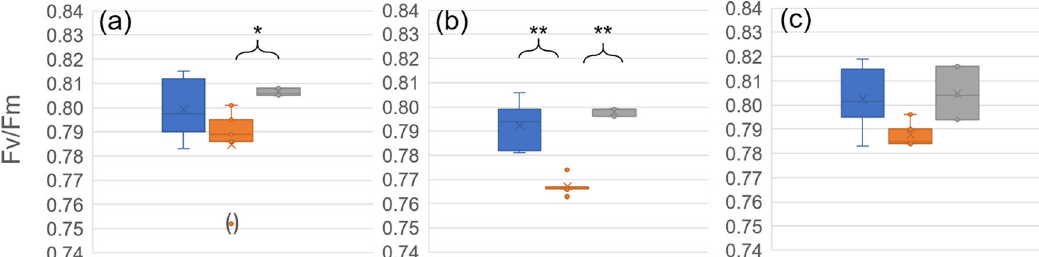
Fig. 3 Maximum photochemical quantum yield of PSII (Fv/Fm) under transient heat. Fv/Fm under 22 °C during the fi rst 2 h of the light phase (blue), during transient exposure to 40 °C (orange) and after 2 h of recovery at 22 °C (gray). a Col-0, b pgm1 , c spsa1 . Box-and-whisker plots: center line, median; box limits, upper and lower quartiles; whiskers, 1.5× interquartile range; points, outliers. Asterisks indicate signi fi cant differences (ANOVA; * P < 0.05; ** P < 0.01). n = 3 – 6. Experimental data are provided in Supplementary